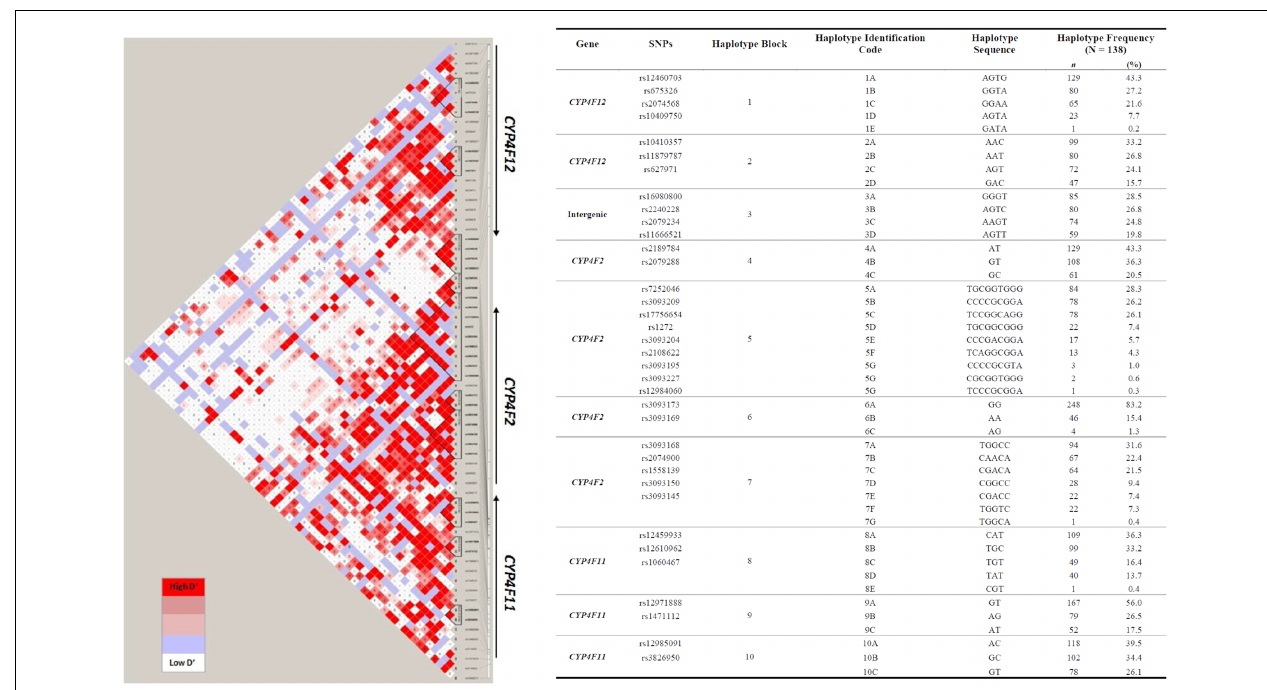
FIGURE 3 | Pairwise LD among polymorphisms in the region of CYP4F12-CYP4F2-CYP4F11 genes in 149 Caucasian samples ( r 2 ≥ 0.9). The left panel shows 10 distinct haplotype blocks defined by the confidence interval algorithm in HaploView 4.2 and the strength of LD is shown in increasing shades of gray, as depicted by the bars. The right panel details the haplotypes sequences and their frequencies inferred by PHASE